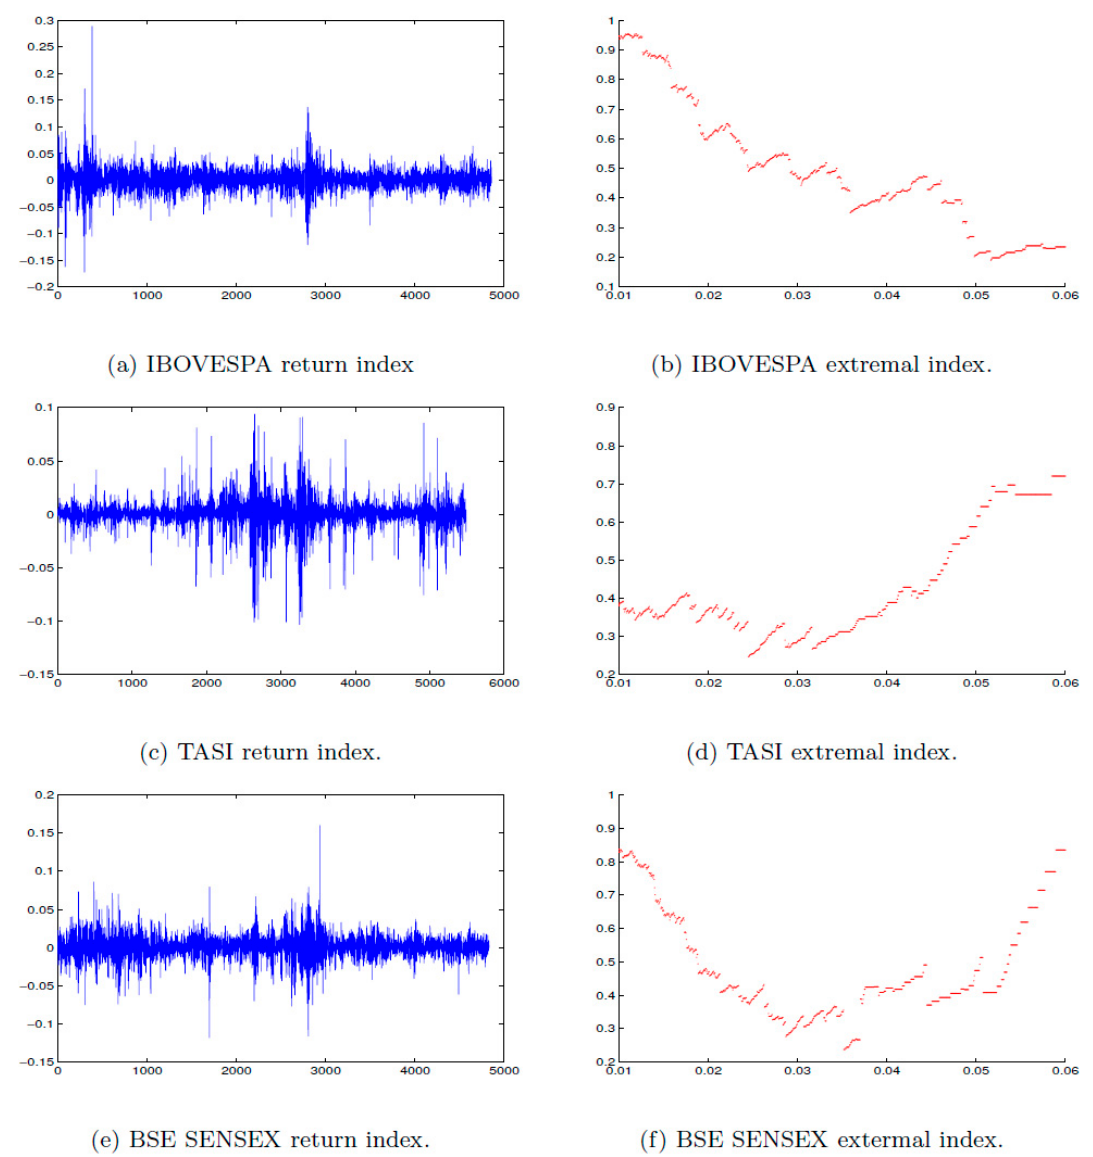
Figure 4. Daily log returns of ( a ) IBOVESPA, ( c ) TASI, ( e ) BSE SENSEX for the period from 1 July 1997 to 16 January 2017, that consists of an average of ( n = 5000) observations. The estimated extremal index of ( b ) IBOVESPA, ( d ) TASI, ( f ) BSE SENSEX at a range of threshold u .